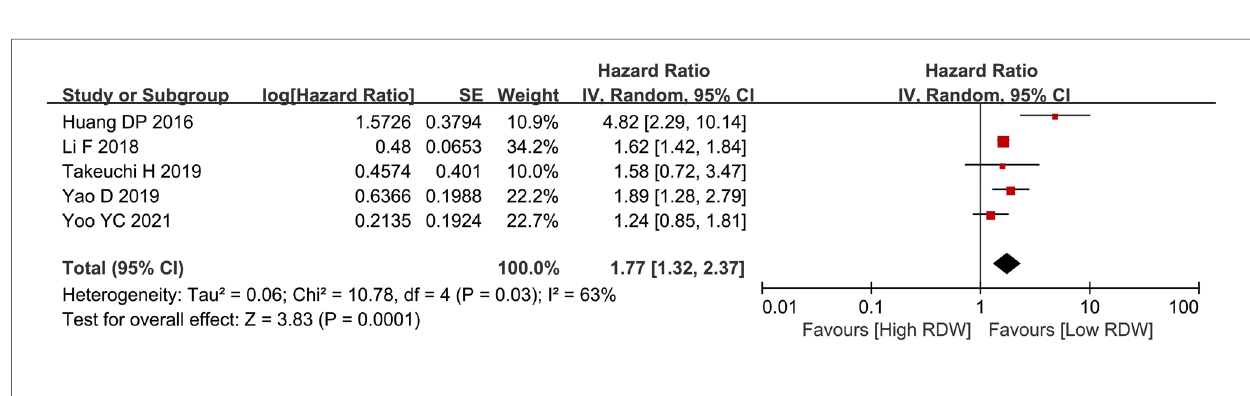
FIGURE 3 DFS between the high RDW group and the low RDW group. Abbreviation: DFS, disease-free survival; RDW, red blood cell distribution